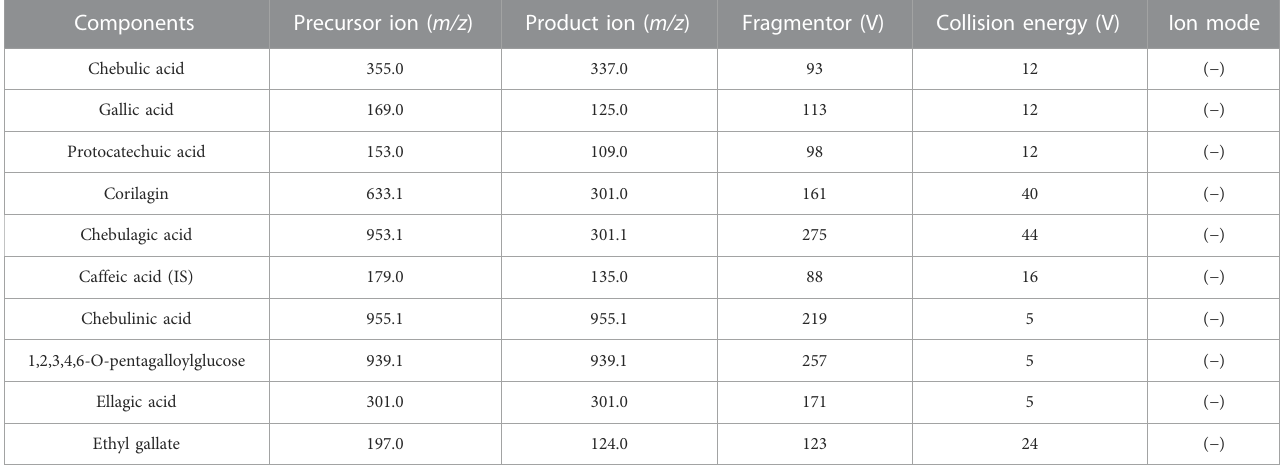
TABLE 1 Mass spectrometry parameters of nine analytes and IS in TC extracts. Components